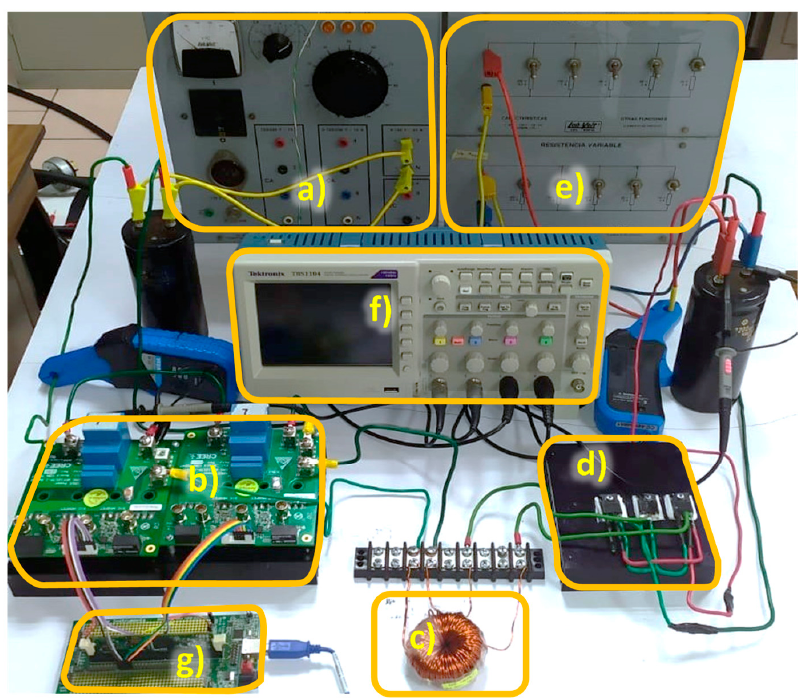
Figure 11. Laboratory prototype of FBDC topology: ( a ) DC variable source 0–120 V, ( b ) Full-bridge,